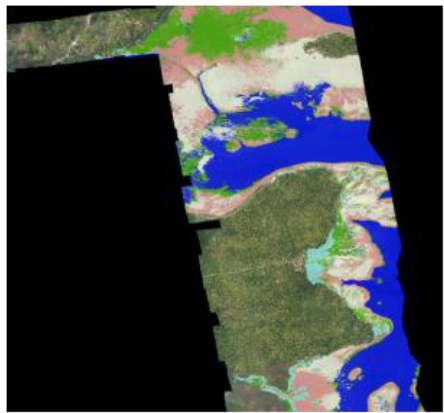
Figure 16. Blk66L0114 (Overall Accuracy: 98.8 % KIA: